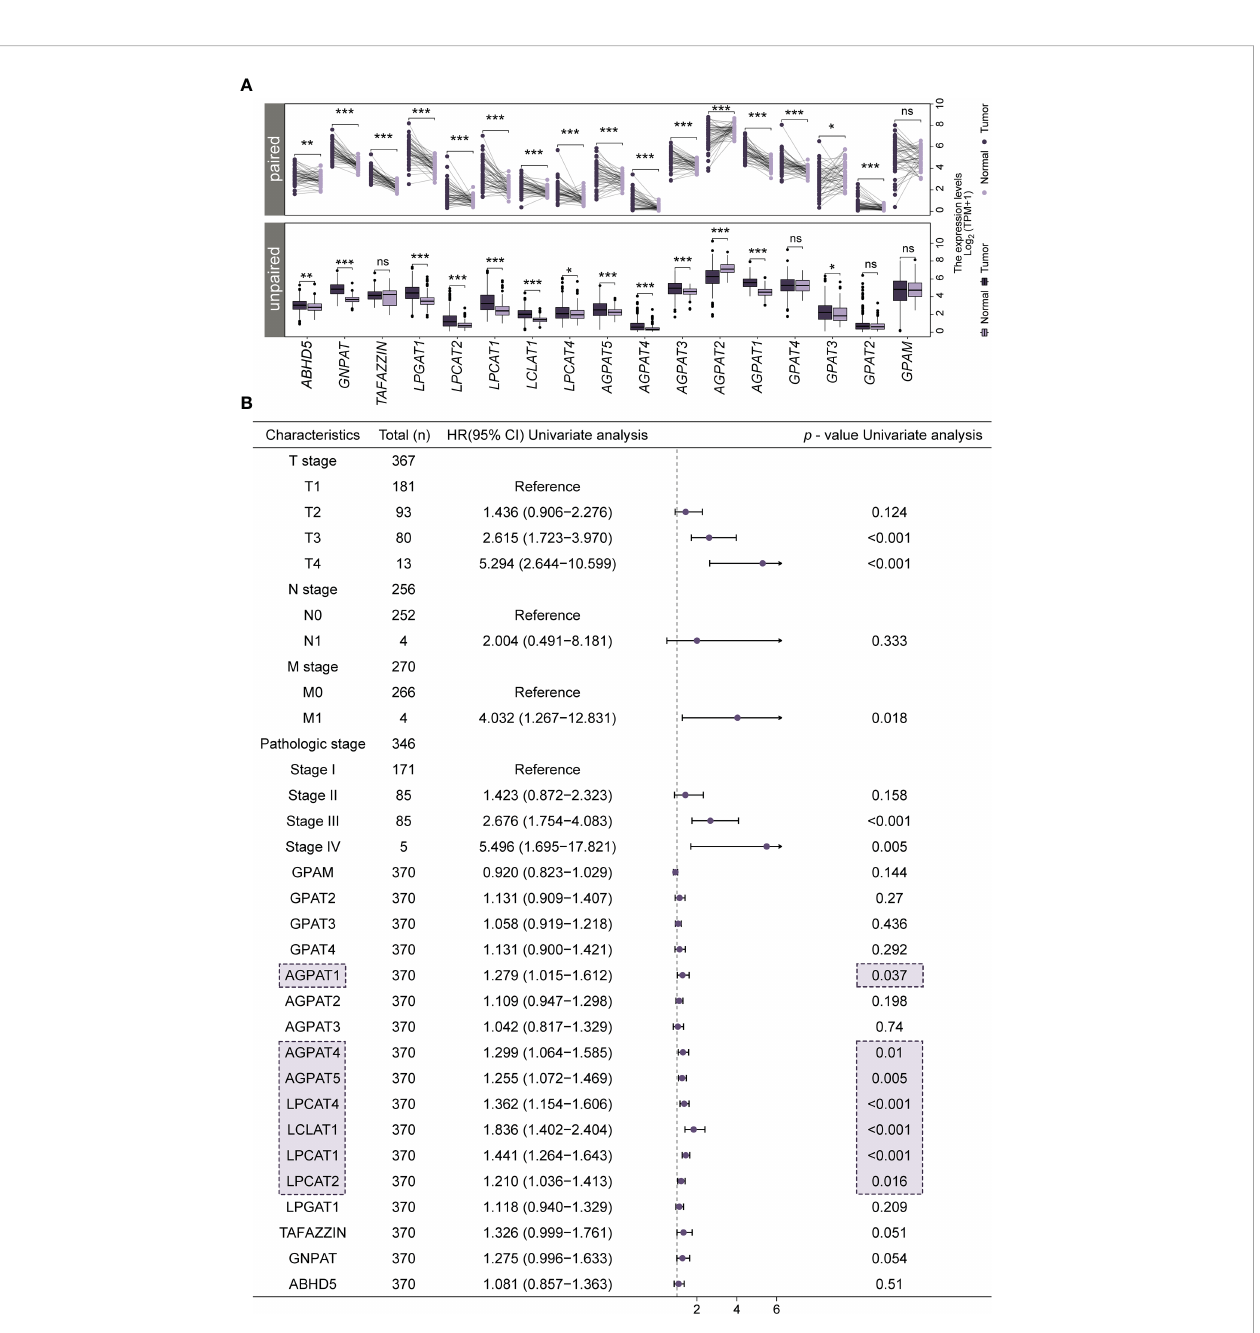
FIGURE 1 Differential expression of GPAT / AGPAT gene family members in HCC patients and forest plots from univariate Cox regression analysis. (A) Differential expression levels of 17 members of the GPAT / AGPAT gene family in paired and unpaired samples of TCGA-LIHC/GTEx. (B) Forest plot for univariate Cox regression analysis. Signi fi cance signs: ns, p ≥ 0.05; *p< 0.05; **p< 0.01; ***p<